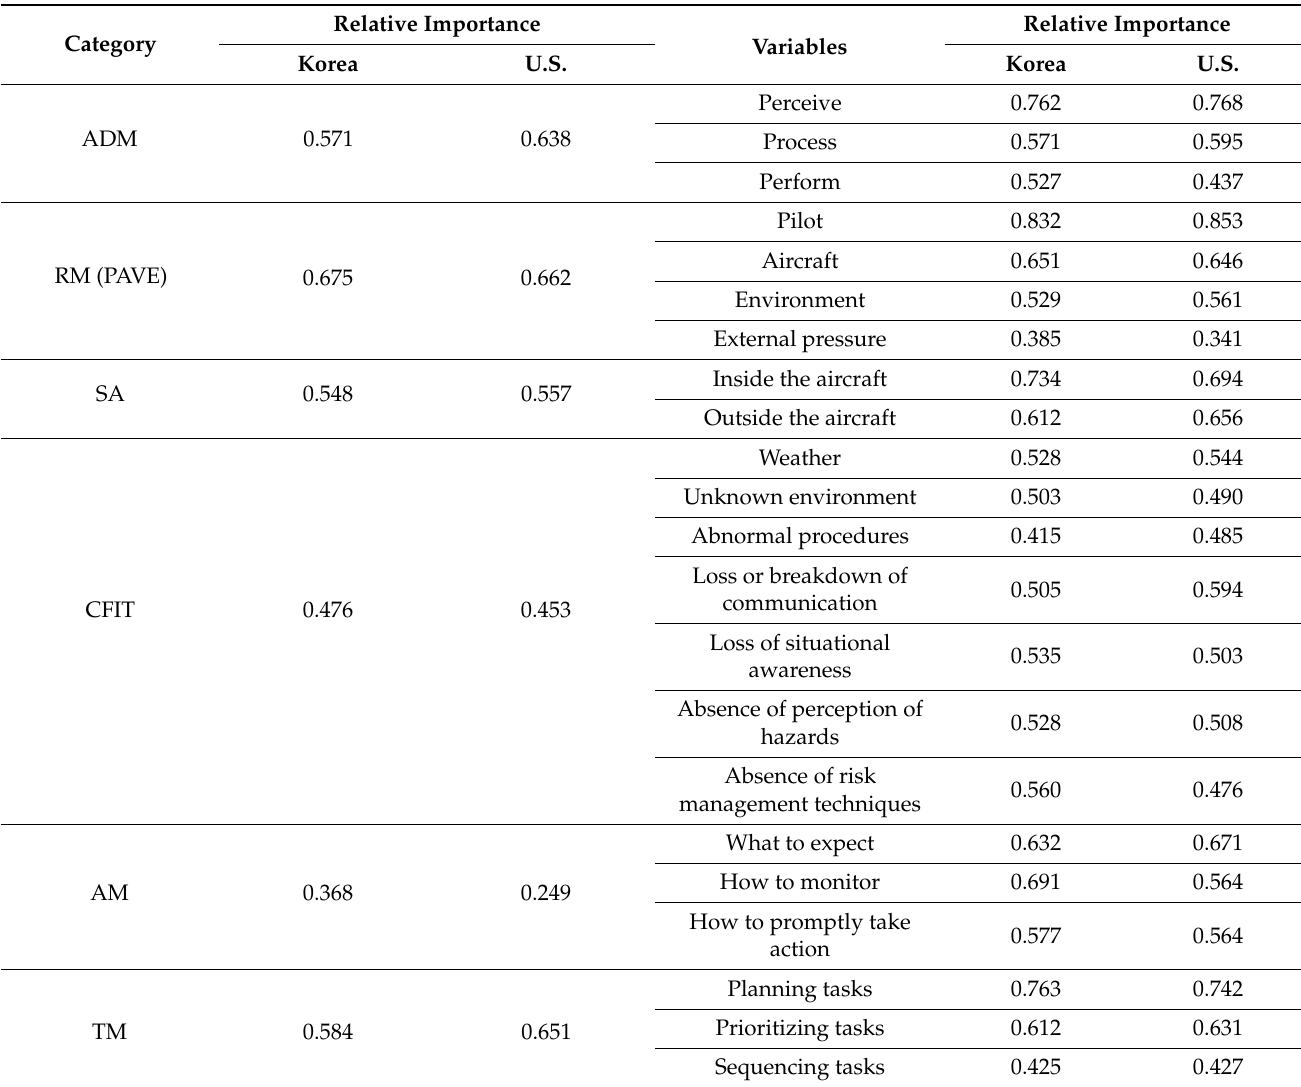
Table 4. Relative Importance of SRM Category and Variables Using Fuzzy